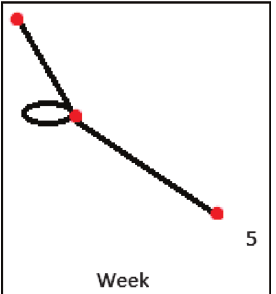
Figure 8. Pattern for